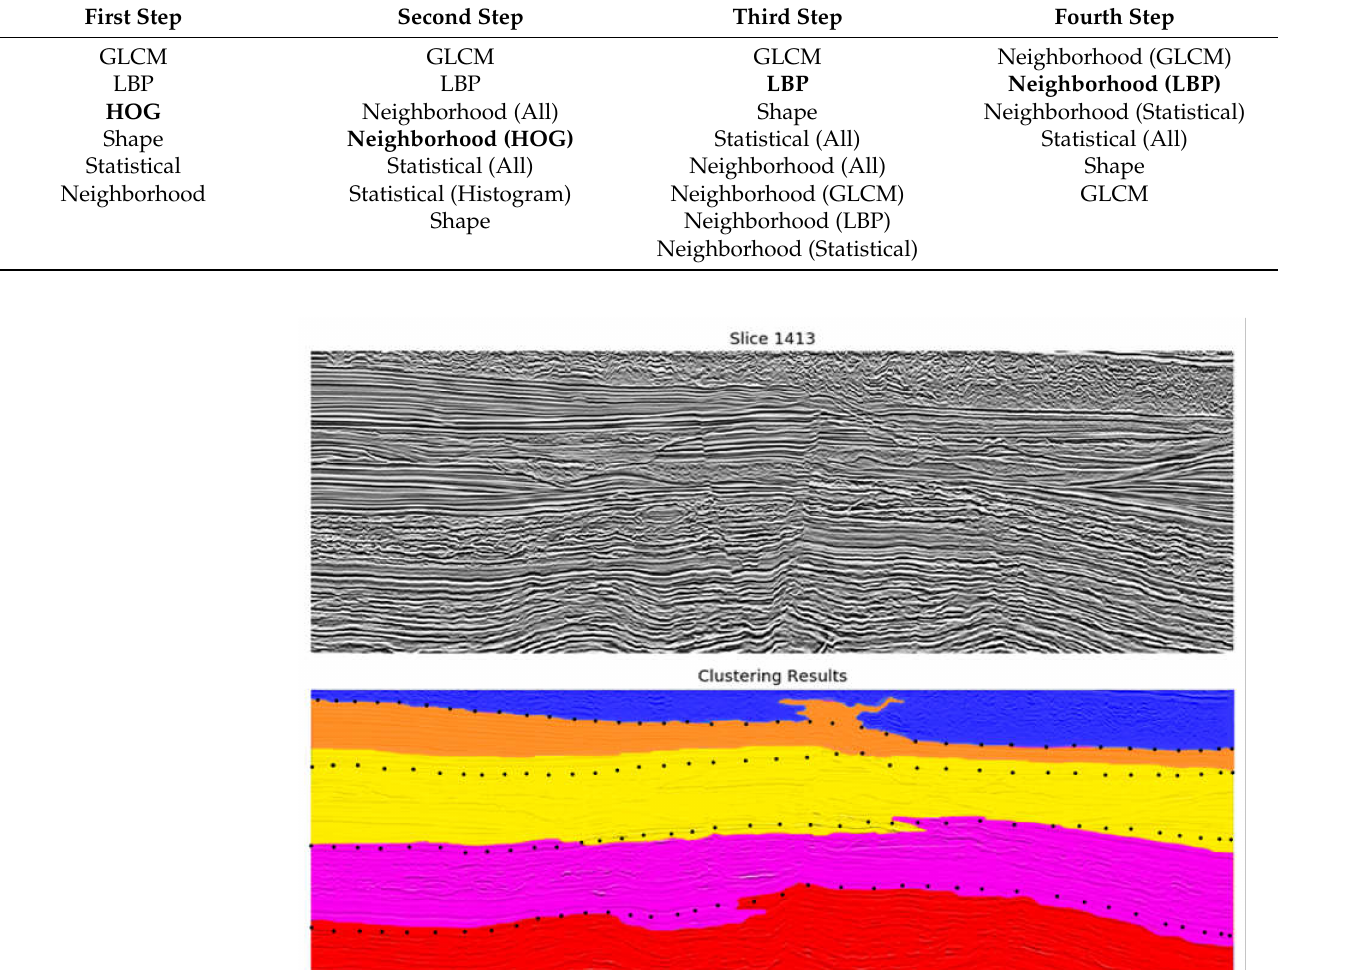
Table 2. Selection of subset of features to represent the segments. In bold are highlighted the features selected in each step.